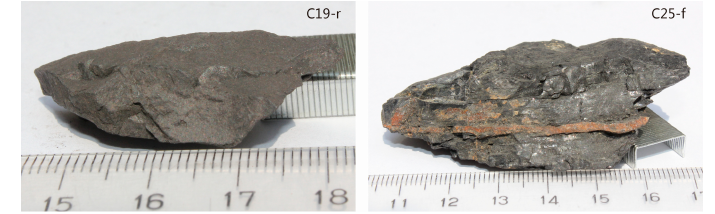
Figure 16. Images of C19-r and C25-f samples collected from the Shiping mine.